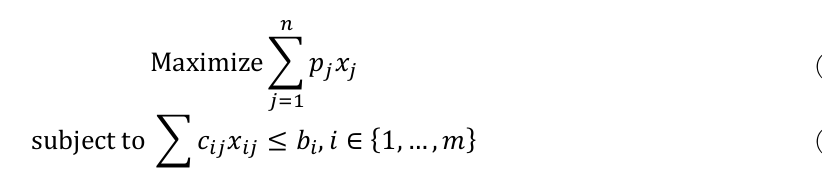
Figure 1. Flowchart of the binary Multi-verse optimizer